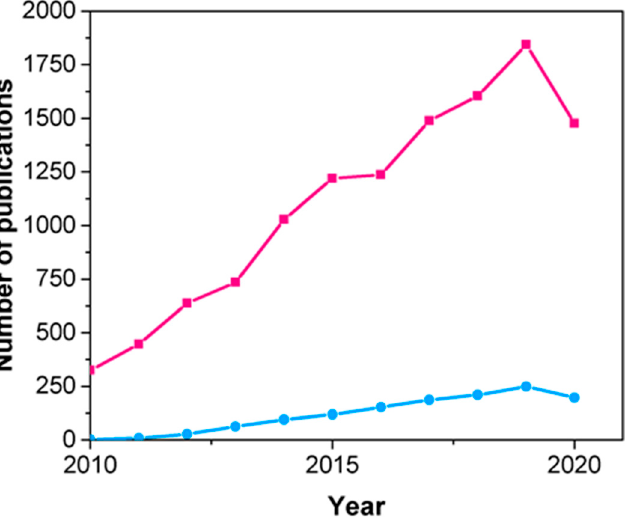
Figure 6. The number of published documents regarding ZnO and graphene materials in photoca- talysis. Keywords: ZnO photocatal* ( ■ ), and ZnO photocatal* graphene ( ● ). Source: Web of